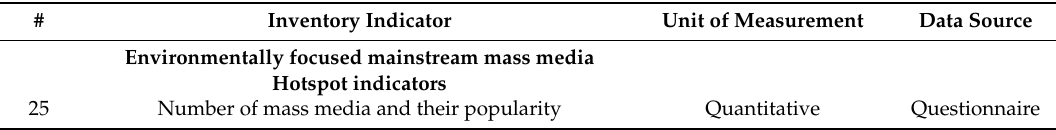
Table 5. Society’s subcategory and